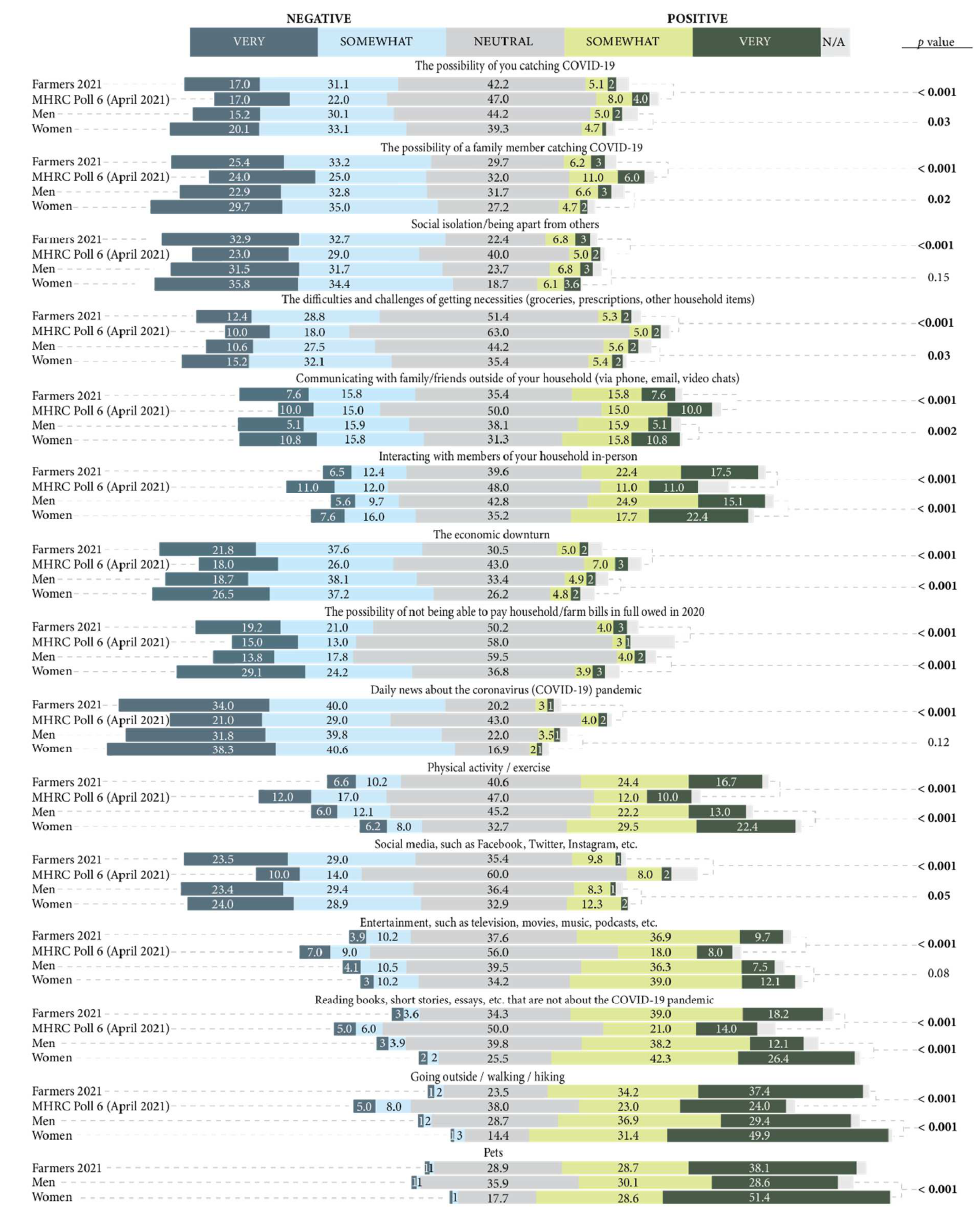
Figure 6. Perceived impact of COVID-19 specific factors on participants’ mental health in comparison to the general Canadian population during COVID-19 and comparison of the 2021 sample by gender (men and women lines).